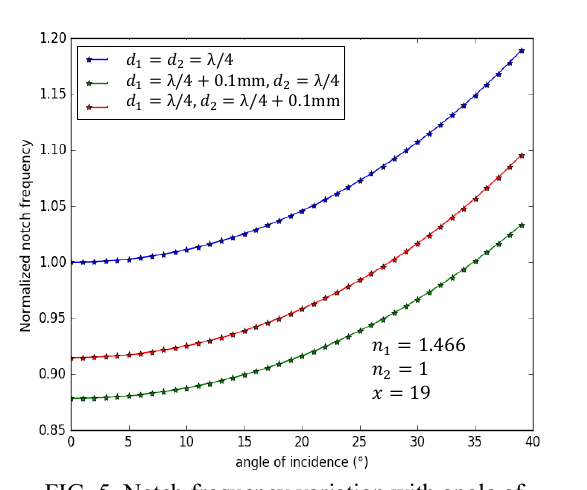
FIG. 5. Notch frequency variation with angle of incidence and thickness of dielectric plates